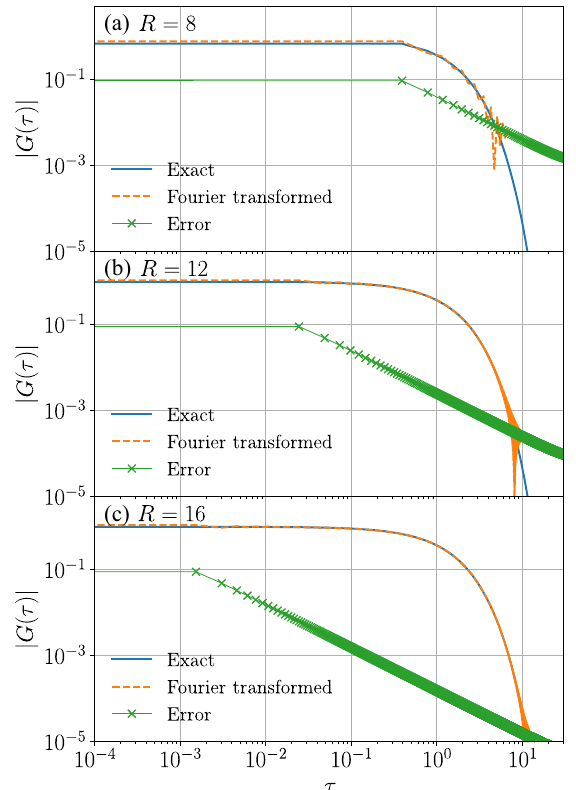
FIG. 23. Fourier transform of the Green ’ s function to the τ domain for R ¼ 8 , 12, 16. The other parameters are the same as in Fig.